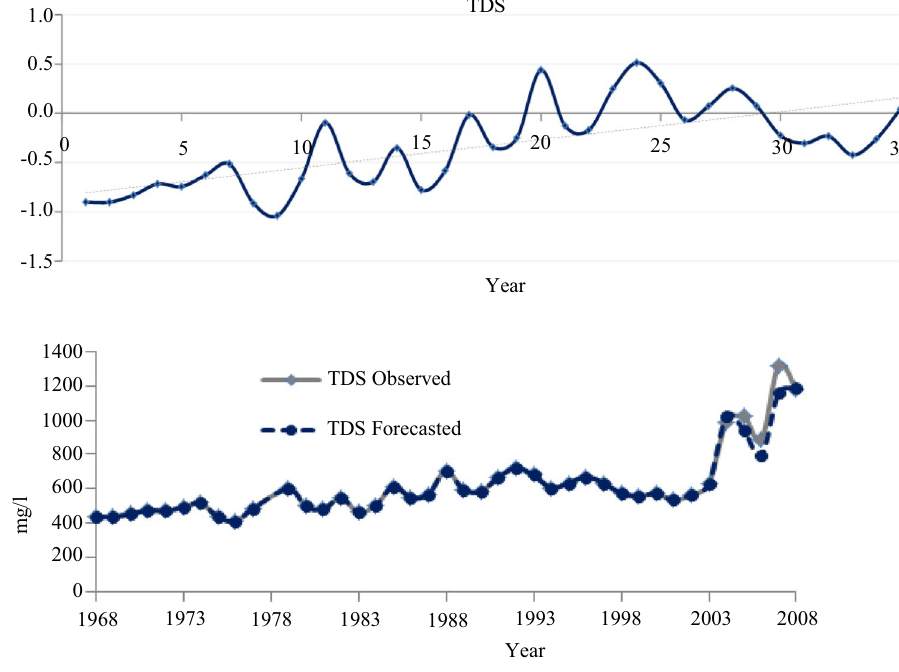
Fig. 2 Unchanging time classi- fication of TDS and the forecast values for 5 years